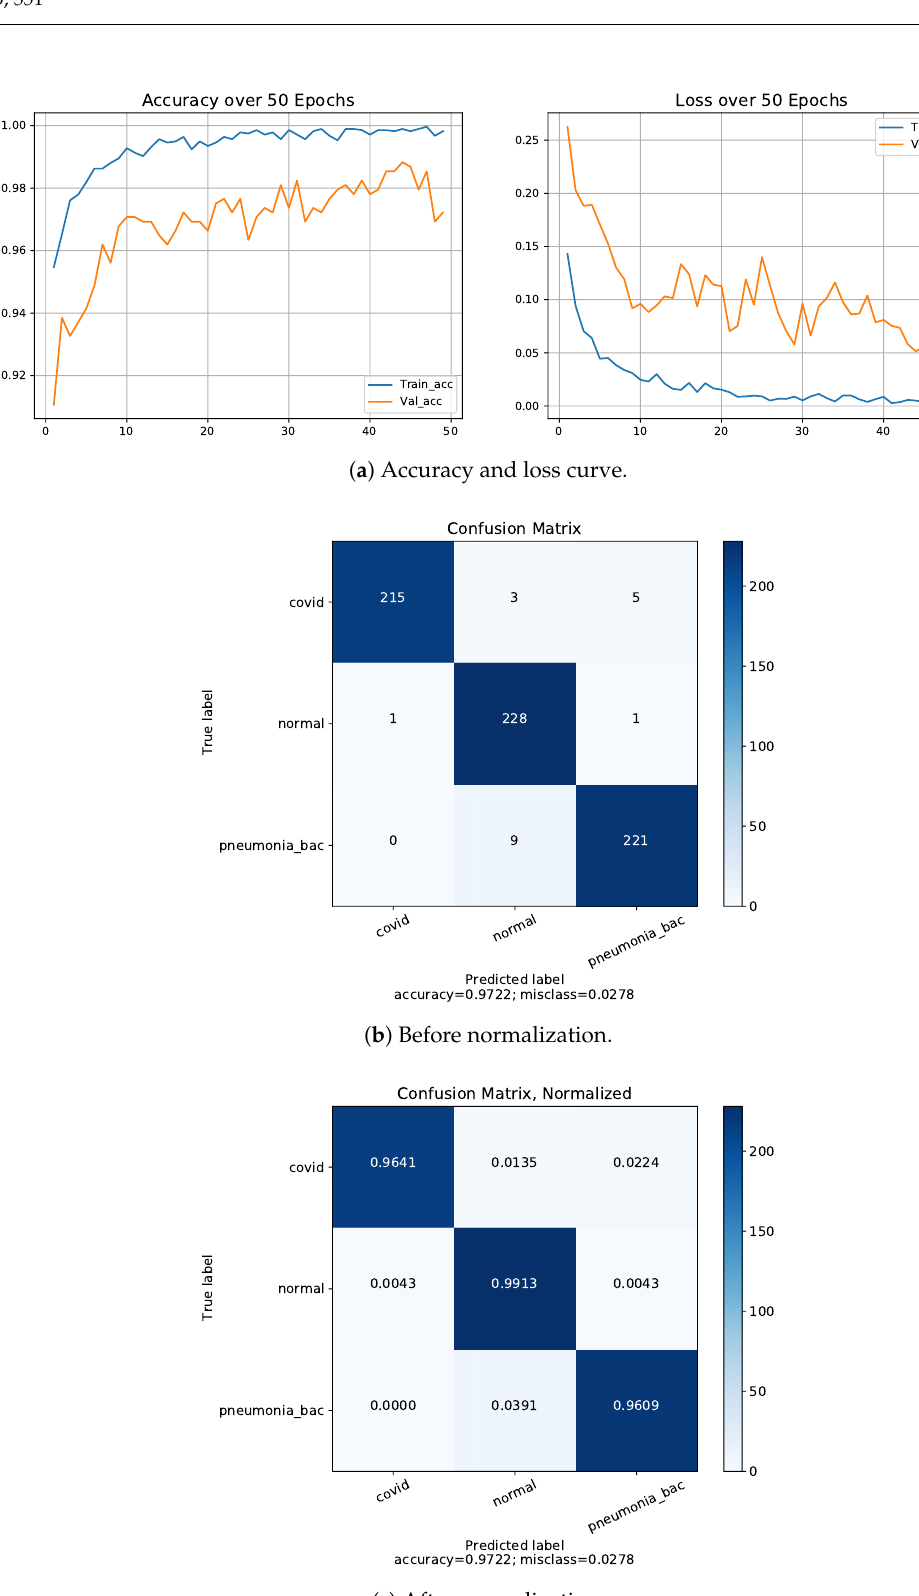
Figure 6. Results of Dataset-1 for 3-class: COVID-19/Normal/bacterial